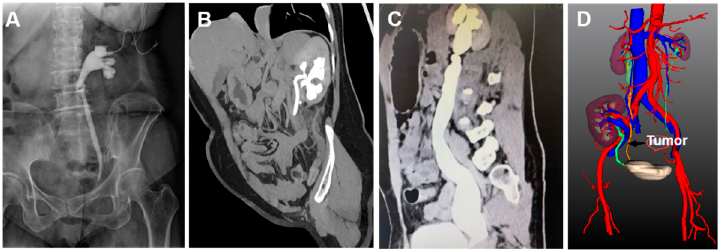
Figure 1. Images of patients. ( A ): Patient 1, KUB figure shows distal ureteral stricture and dilation of renal pelvis and ureter; a nephrostomy tube was implanted; ( B ): patient 12, multidimensional reconstruction CT image shows duplicate kidney and ureter; the ureter shows Y-shaped duplication; ( C ): patient 13, reconstructed CT image shows full-length dilation of the renal pelvis and ureter, as well as distal ureteral stricture; ( D ): patient 14 underwent renal transplantation and has a secondary tumor of the native ureter. CT three-dimensional reconstruction image shows that the native ureter is closely adjacent to the renal artery of the transplanted